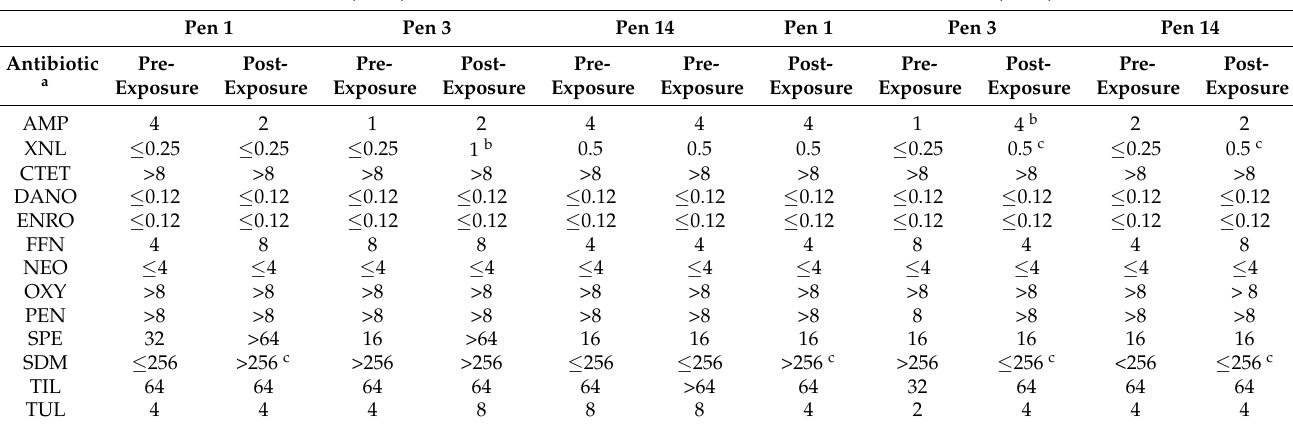
Table 3. Antimicrobial susceptibilities of presumptive E. coli isolated from rectal swabs of pigs before or after feed administration of 18 mg of thymol- β - D -glucopyranoside/kg body weight. Presumptive E. coli Isolates Recovered Before (Pre-) and 16 h After (Post-)